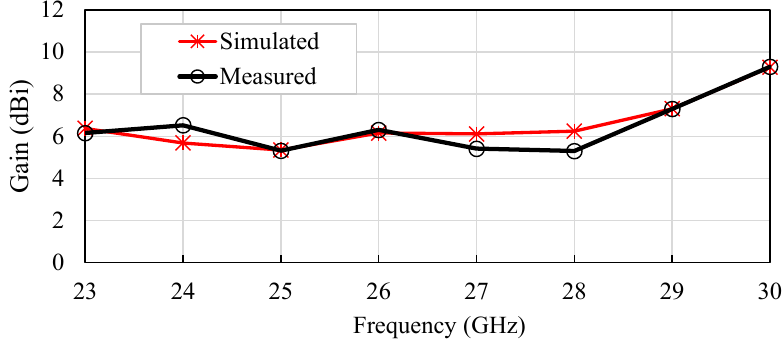
Figure 12. Measured and simulated gains from 23 to 30 GHz at θ = 0 ◦ .